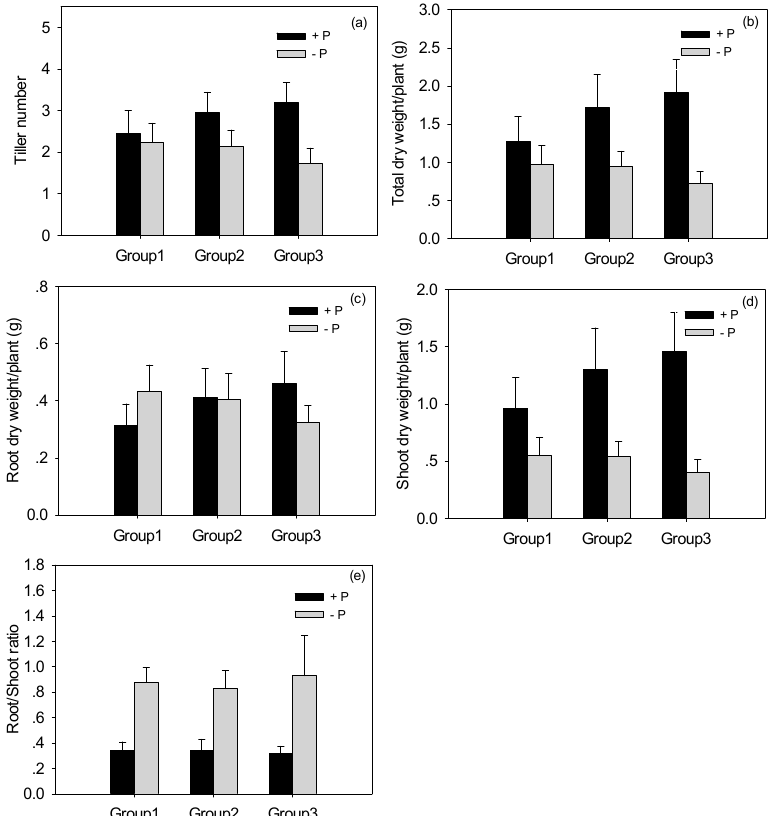
Figure 2. Mean and standard deviation of five traits related to Phosphorus deficiency tolerance index (PDTI) in three genotypic groups under +P and − P. Groups 1, 2, and 3 represent high, moderate, and low tolerances under phosphorus deficiency. Number of rice accessions in Groups 1, 2, and 3 are 22, 107, and 37, respectively. ( a ) the tiller number under +P and − P of three genotypes groups, ( b ) total dry weight per plant of three genotypes group under +P and − P, ( c ) the root dry weight per plant of three genotypes groups under +P and − P, ( d ) the shoot dry weight of each genotypes group under +P and − P and ( e ) is the root/shoot ratio of each genotypes groups under +P and − P.